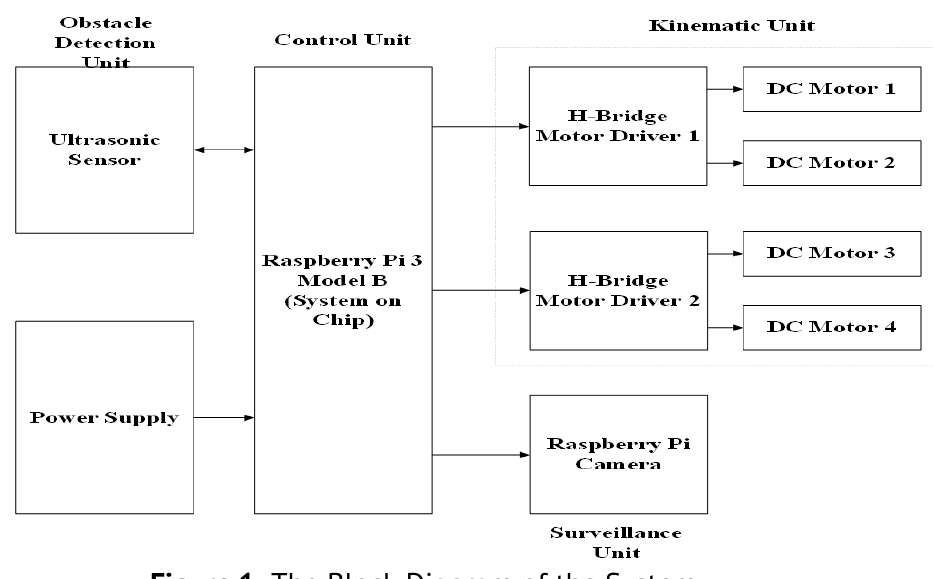
Figure 1. The Block Diagram of the